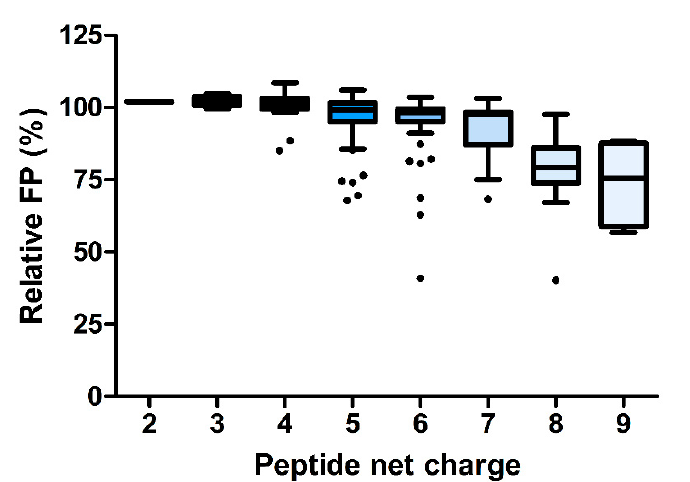
Figure 5. Standard boxplots (Tukey) showing the correlation of peptide net charges and relative FP values for ARV-1502 and 176 ARV-1502 analogs.